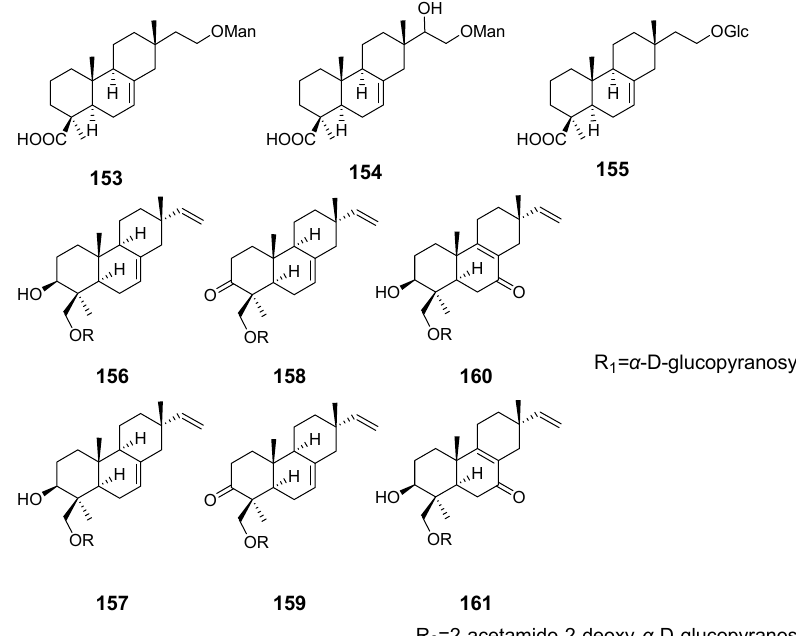
Pharmaceuticals 2022 , 15 , x FOR PEER REVIEW Figure 15. Structures of compounds 153 – 161 . Figure 15. Structures of compounds 153 – 161 .